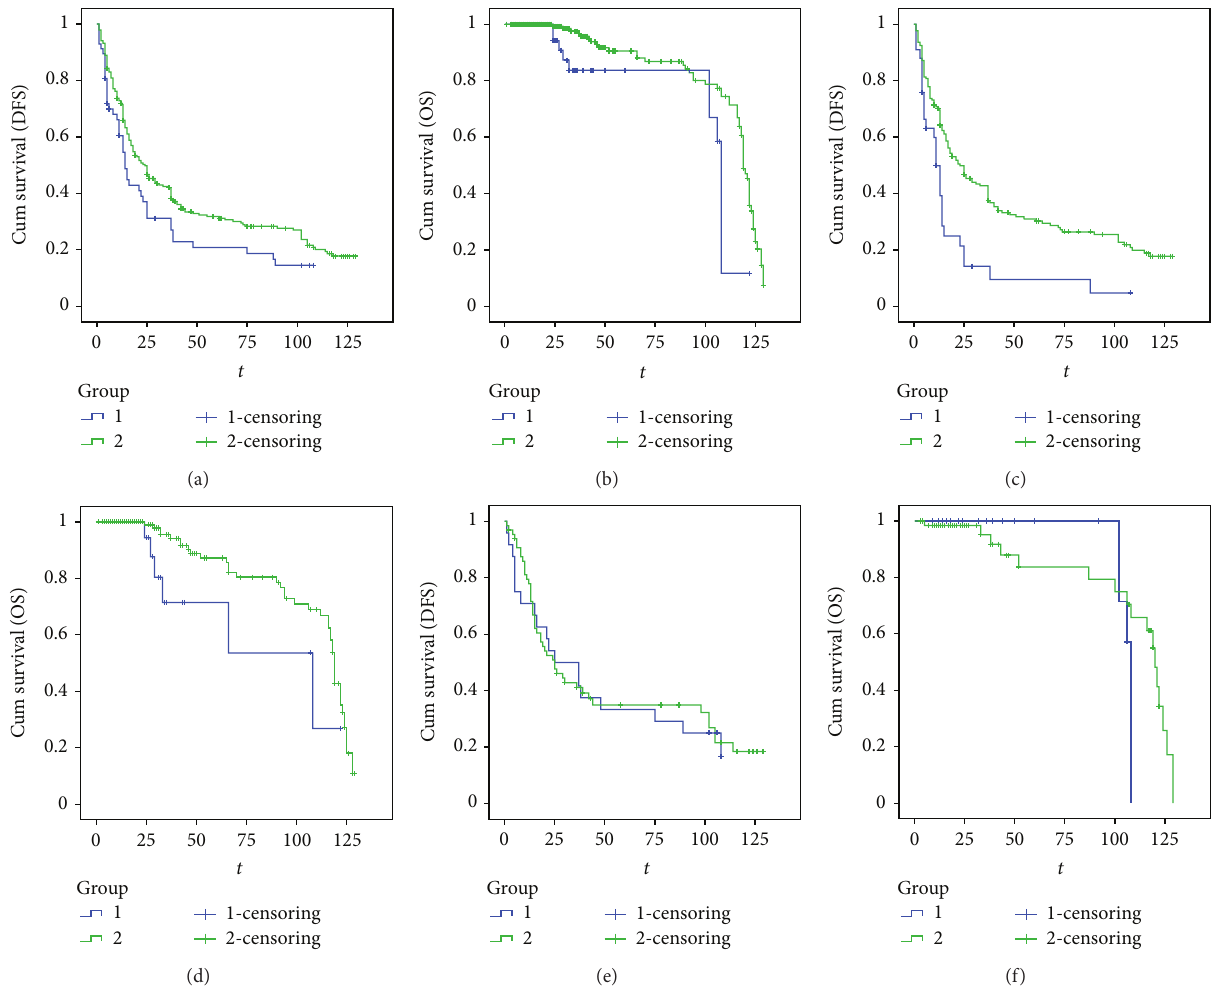
Figure 2: Relationship between DFS or OS and CADM1/TSLC1 expression. (a) Relationship between DFS and CADM1/TSCL1 expression in all patients with ESCC; (b) Kaplan-Meier curves for the correlation between OS and CADM1/TSCL1 expression in all patients with ESCC; (c) Kaplan-Meier curves for the correlation between DFS and CADM1/TSCL1 expression in male patients with ESCC; (d) Kaplan-Meier curves for the correlation between OS and CADM1/TSCL1 expression in male patients with ESCC; (e) Kaplan-Meier curves for the correlation between DFS and CADM1/TSCL1 expression in female patients with ESCC; (f) Kaplan-Meier curves for the correlation between OS and CADM1/TSCL1 expression in female patients with